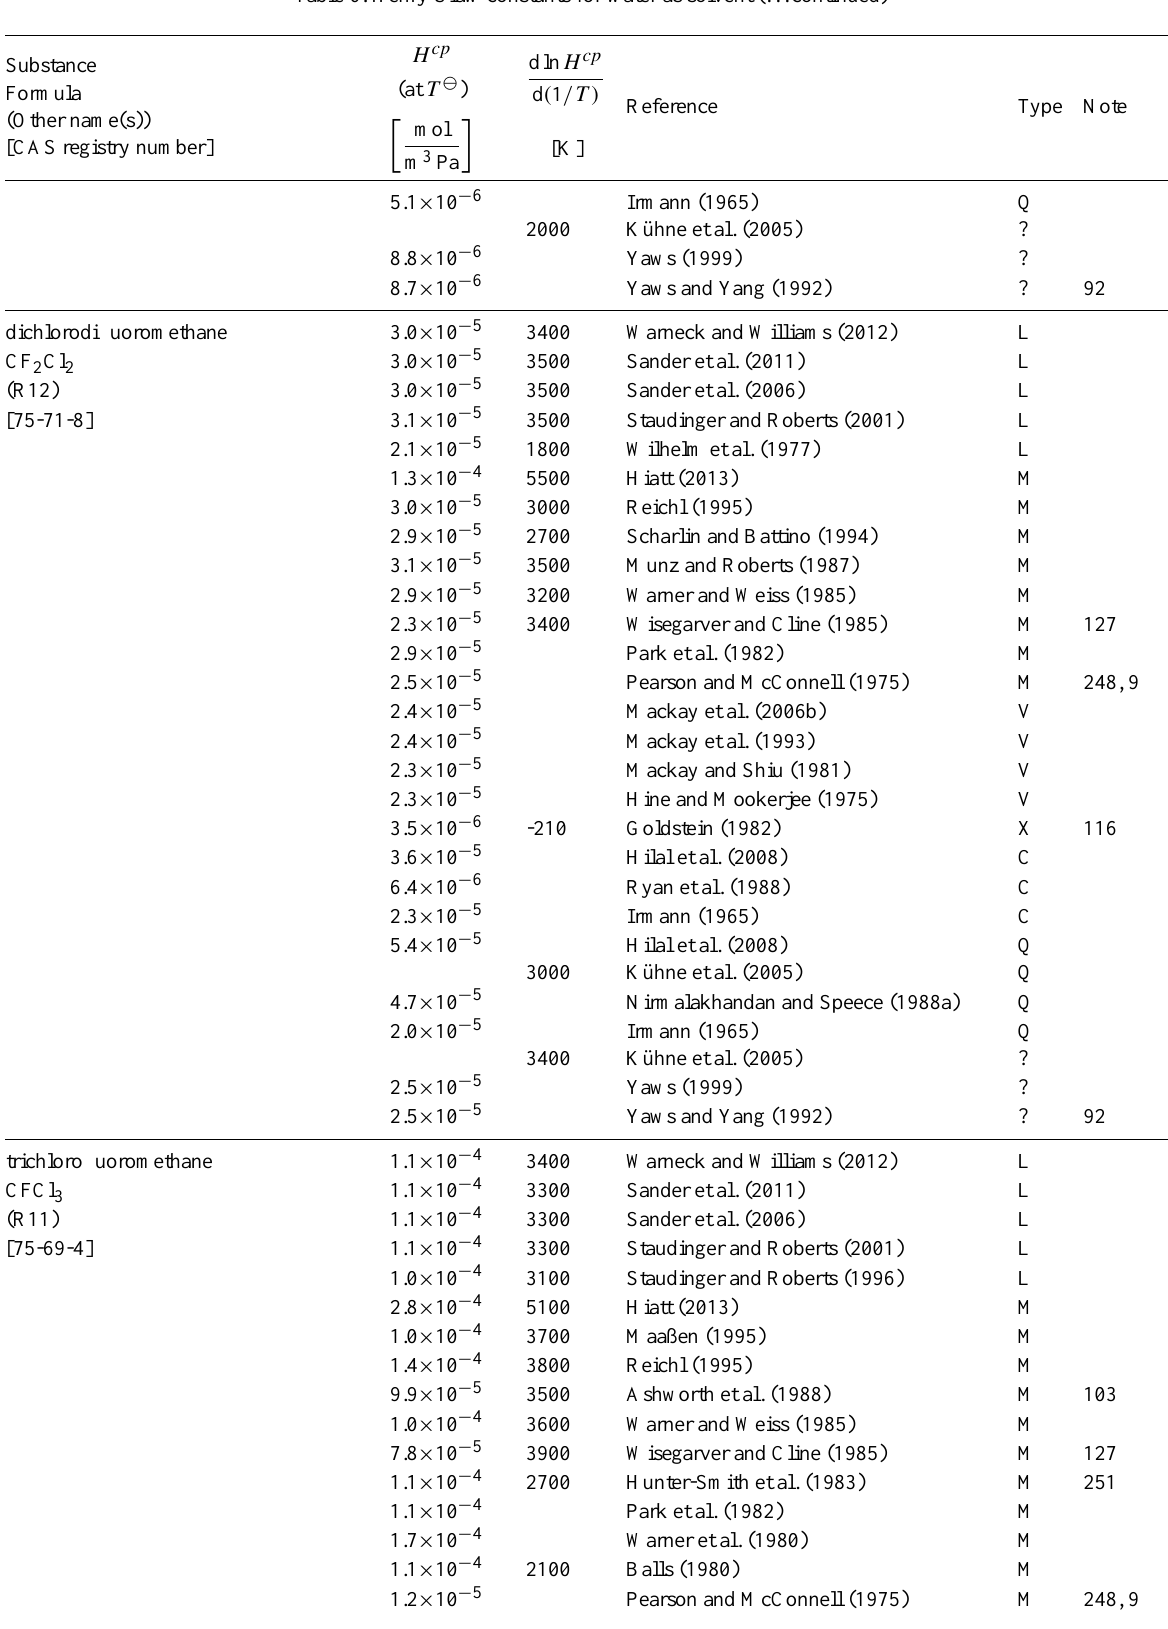
Table 6: Henry’s law constants for water as solvent